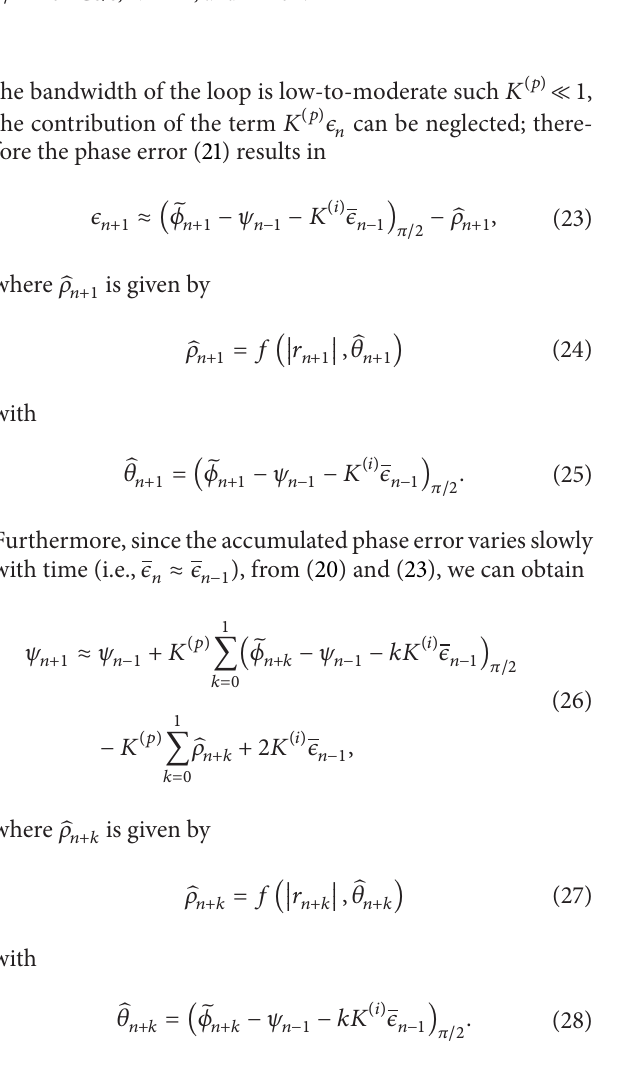
Figure 12: Laser linewidth tolerance in the presence of vibration- induced frequency fluctuations for Δ𝑓 𝑐 = 35 KHz, 𝐴 𝑝 = 140 MHz, 1/𝑇 = 32 Gs/s, 𝑁 = 21 , and 𝐵 = 32 .